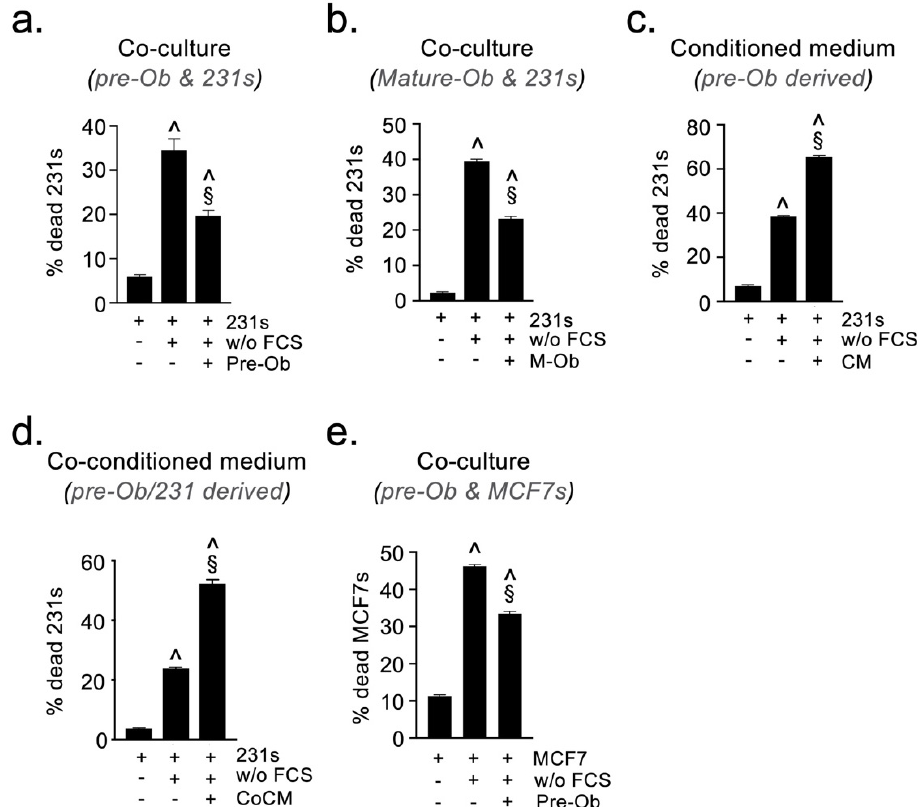
Figure 5. Osteoblast-derived juxtacrine signals protect hormone receptor positive and negative BCCs from serum-deprivation induced cell death. Flow cytometric quantification MDA-MB-231 viability in serum-starvation assays performed in the presence of ( a ) pre-osteoblastic cells, ( b ) mature osteoblasts ( c ) pre-Ob conditioned medium, ( d ) pre-Ob and MDA-MB-231 co-conditioned medium. ( e ) Quantification of MCF7 viability in serum-starvation assays performed in the presence of pre-Ob. (w/o FCS = without FCS, M-Ob = mature osteoblasts; ˆ sig. dif. w.r.t. BCCs in full serum ( p < 0.001), § sig. dif. w.r.t. BCC without serum ( p < 0.001); n = 4 per condition).